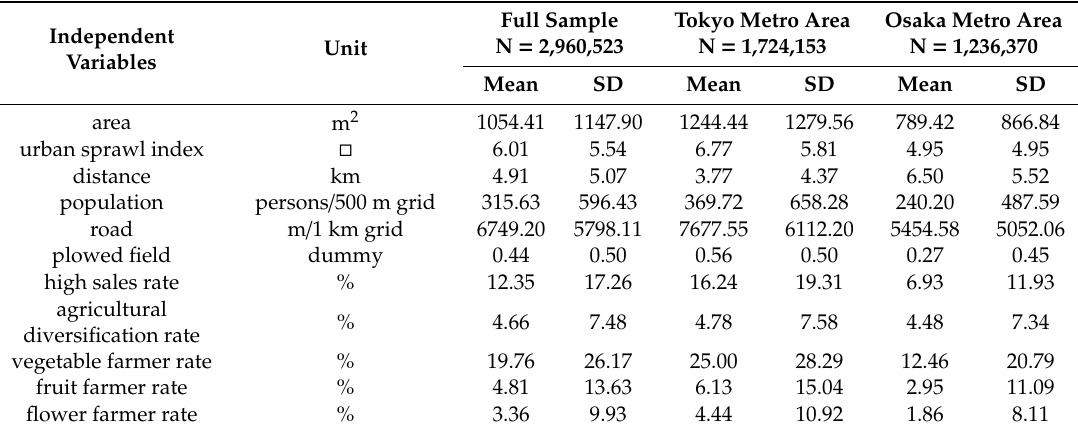
Table 3. Descriptive statistics of farmland